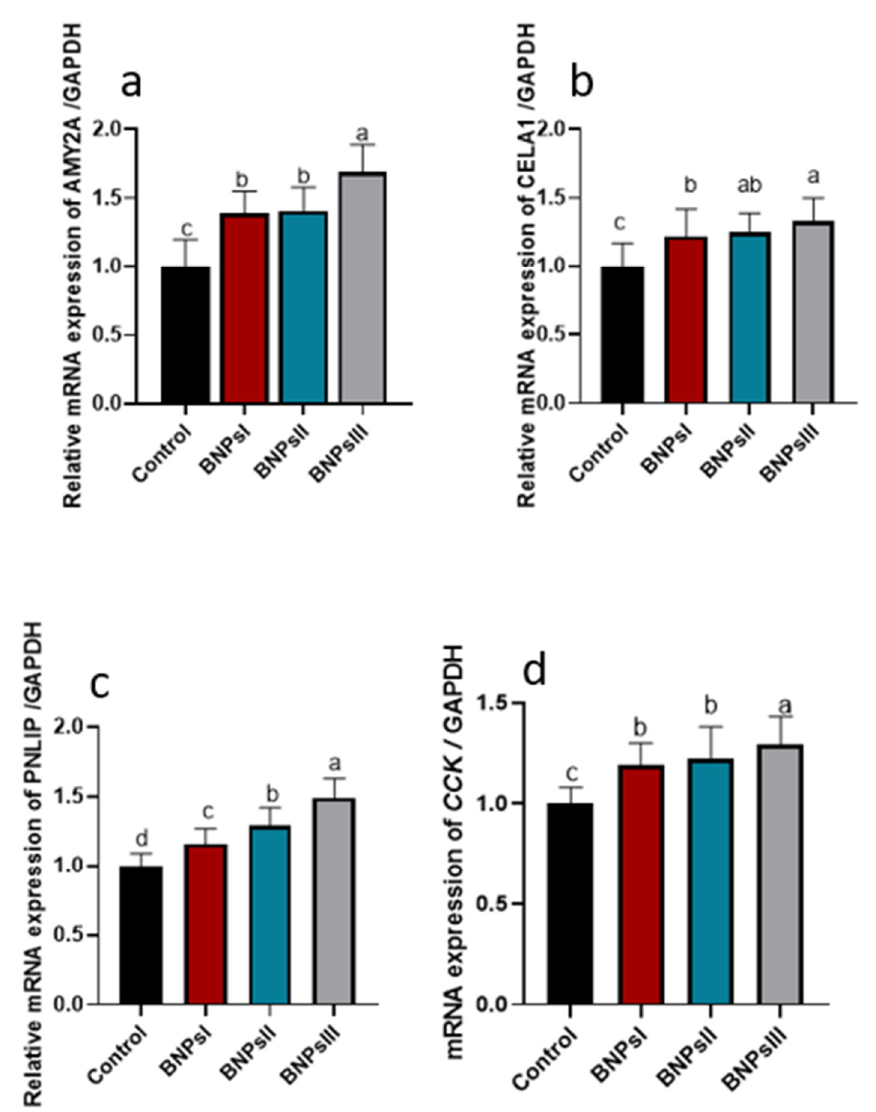
Figure 2. Effect of feeding Ross broilers ( n = 5/group) different levels of Bacillus amyloliquefaciens - encapsulated nanoparticles (BNPs I, II, and III) on the expression of digestive enzymes-related genes compared to birds fed basal diet. Graphs represented the relative mRNA expression of alpha 2A amylase ( AMY2A , ( a )), chymotrypsin-like elastase family member 1 ( CELA1 , ( b )), pancreatic lipase ( PNLIP , ( c )), and cholecystokinin ( CCK , ( d )). The data represented the relative mRNA expression normalized to GAPDH and the significance is p < 0.05. a–d Mean values within columns showing numerous letters differ statistically.